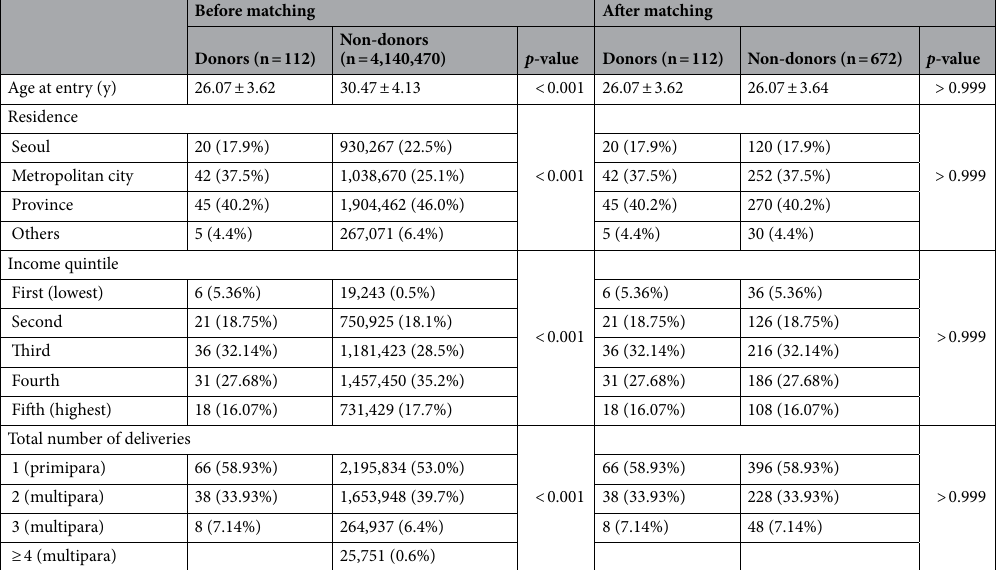
Table 1. Baseline characteristics of donors and non-donors before and after propensity score matching.